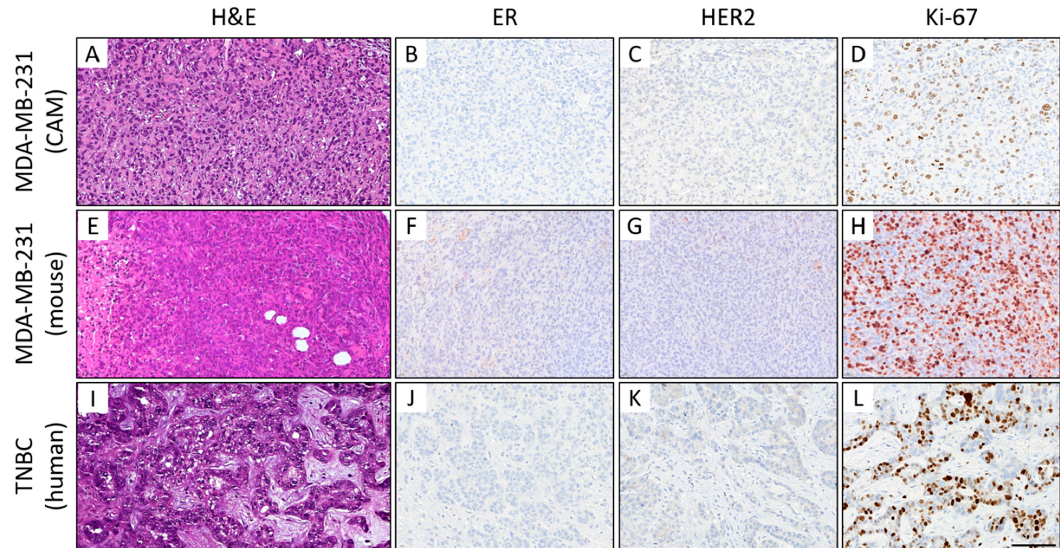
Figure 7. Histological ( A – C ) and immunohistochemical comparison of MDA-MB-231 CAM ovografts ( A – D ), MDA-MB-231 murine xenografts ( E – H ), and human TNBC tumor tissue ( I – L ). Representative images of the histomorphology (hematoxylin and eosin) and immunohistochemical expression profile: Expression of estrogen receptor (ER; B , F , J ), human epidermal growth factor receptor 2 (HER2; C , G , K ), and the proliferation marker Ki-67 ( D , H , L ) (magnification: x400 each). All three tumors presented a TNBC phenotype with a high-grade morphology, negativity for ER/PR (PR not shown) and HER2, and a high Ki-67 proliferation index. Of note, the mouse xenografts showed some nonspecific background staining (for higher magnification, see Supplemental Figure S4), which should not be confused with specific nuclear and membranous staining of the tumor cells. Scale bar: 100 µm ( applies to both cell lines and all images ) .